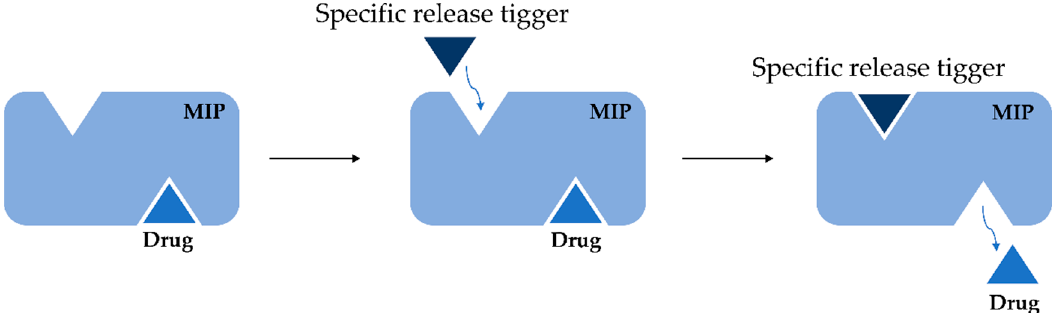
Figure 7. Scheme of intelligent drug release from MIP.